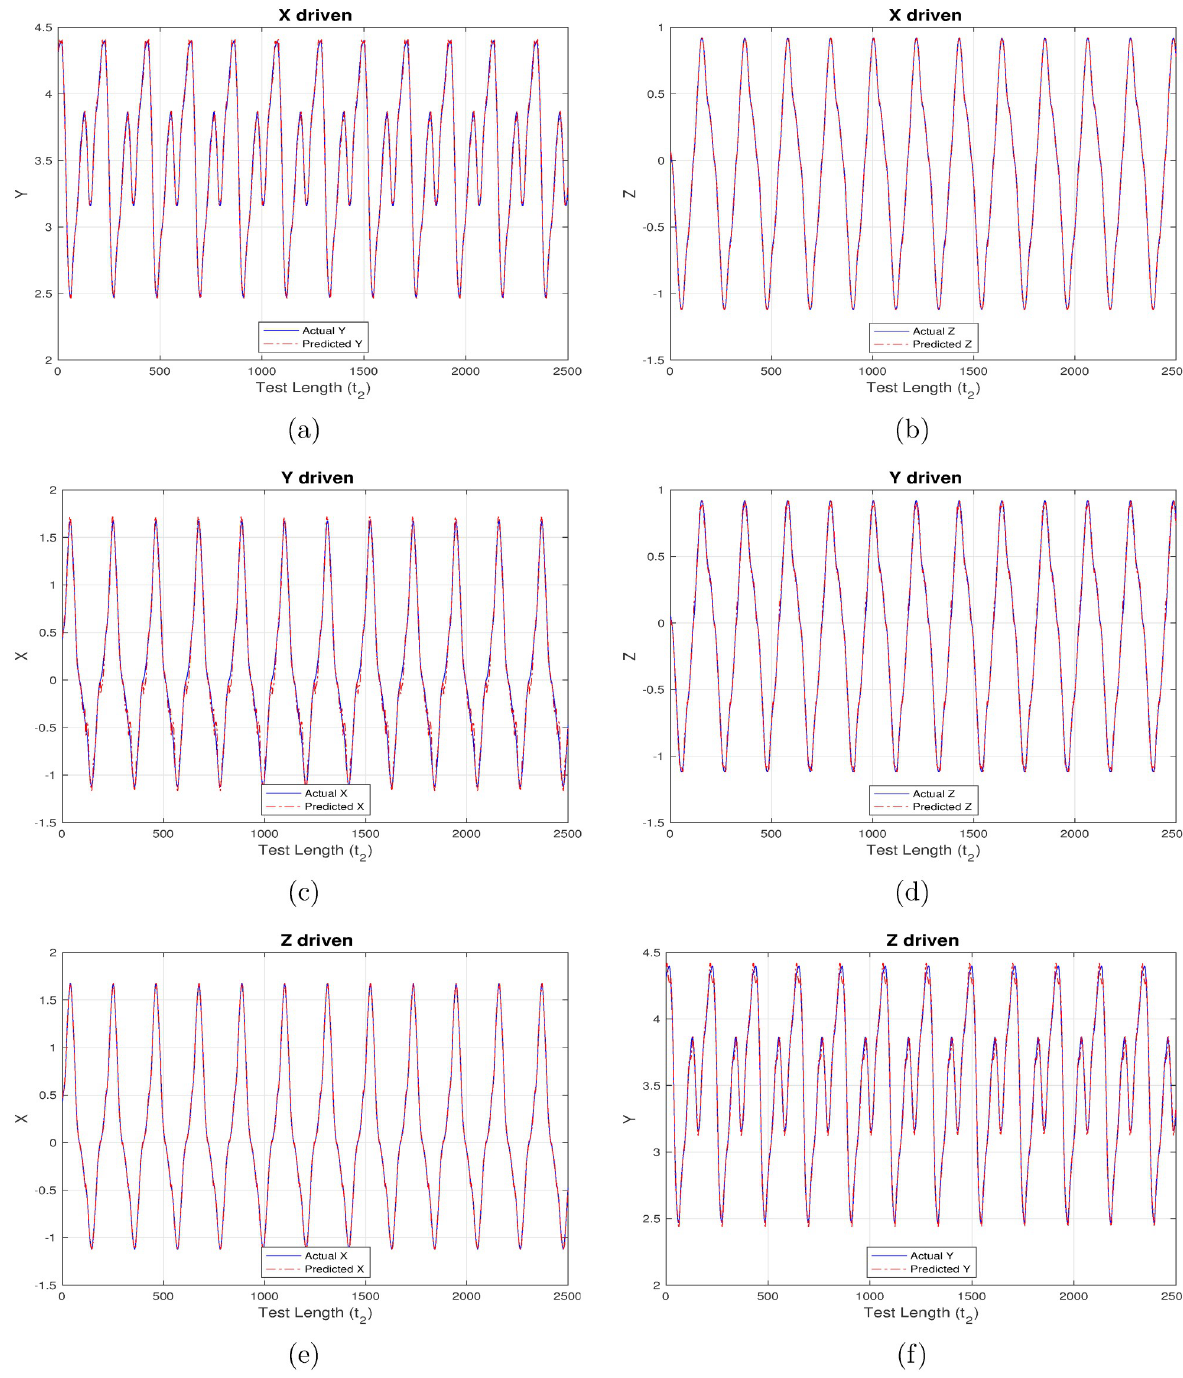
Fig 9. Controlled (time-delayed feedback) financial system component re-generation using “non-linear” activation. (a) Re-generating “investment demand” [Y] behavior with “interest rate” [X] as input (b) Re-generating “price index” [Z] behavior with “interest rate” [X] as input (c) Re-generating “interest rate”[X] behavior with “investment demand”[Y] as input (d) Re-generating “price index” [Z] behavior with “investment demand” [Y] as input (e) Re-generating “interest rate” [X] behavior with “price index” [Z] as input (f) Re-generating “investment demand” [Y] behavior with “price index” [Z] as